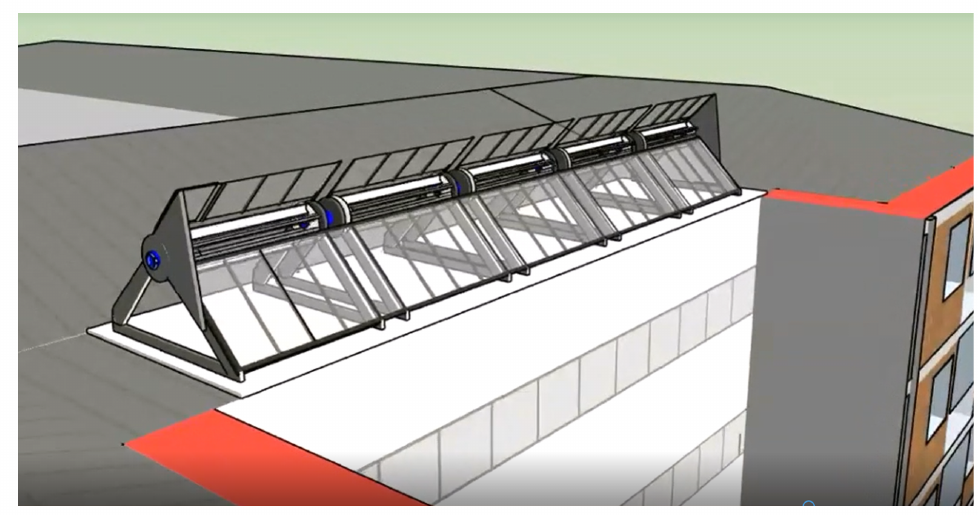
Figure 4. ROSEO-BIWT design.